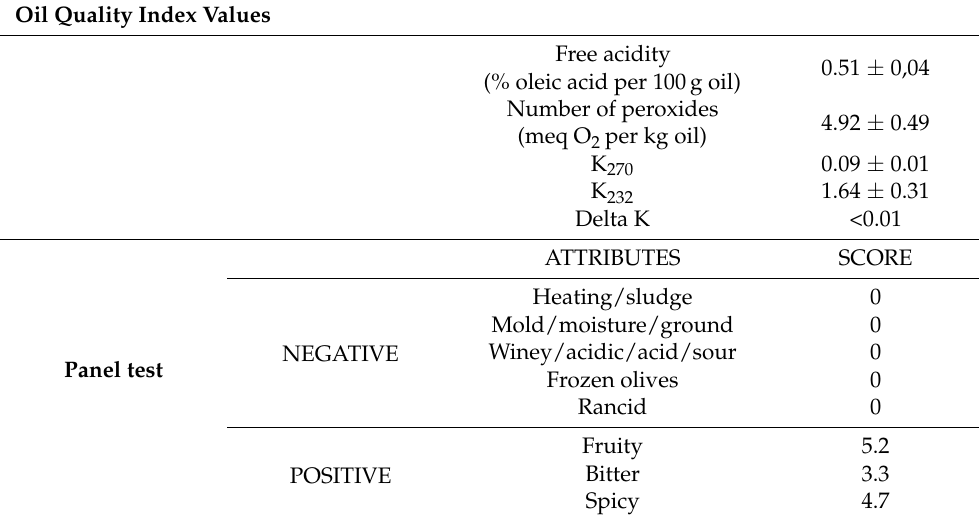
Table 2. Quality indices and panel test of extra virgin olive oil extracted by cultivar “Oliva Bianca”. The parameters are reported as means ± SD of three different replicates ( n =